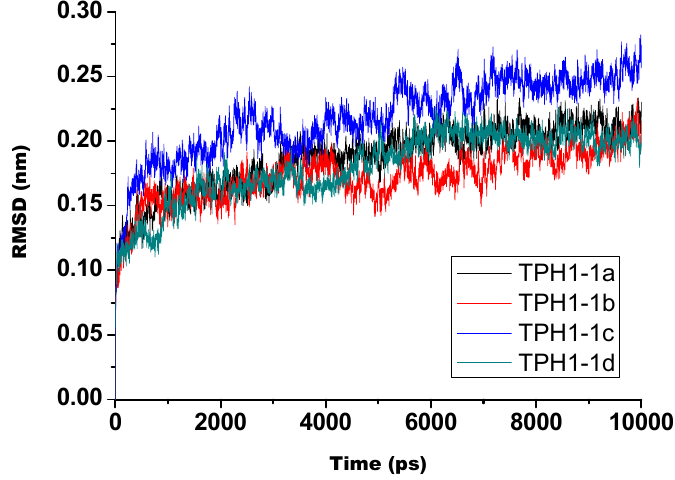
Figure 2. The root-mean-square deviations (RMSD) of the backbone atoms relative to their initial minimized complex structures as a function of time for 1a (black), 1b (red), 1c (blue) and 1d